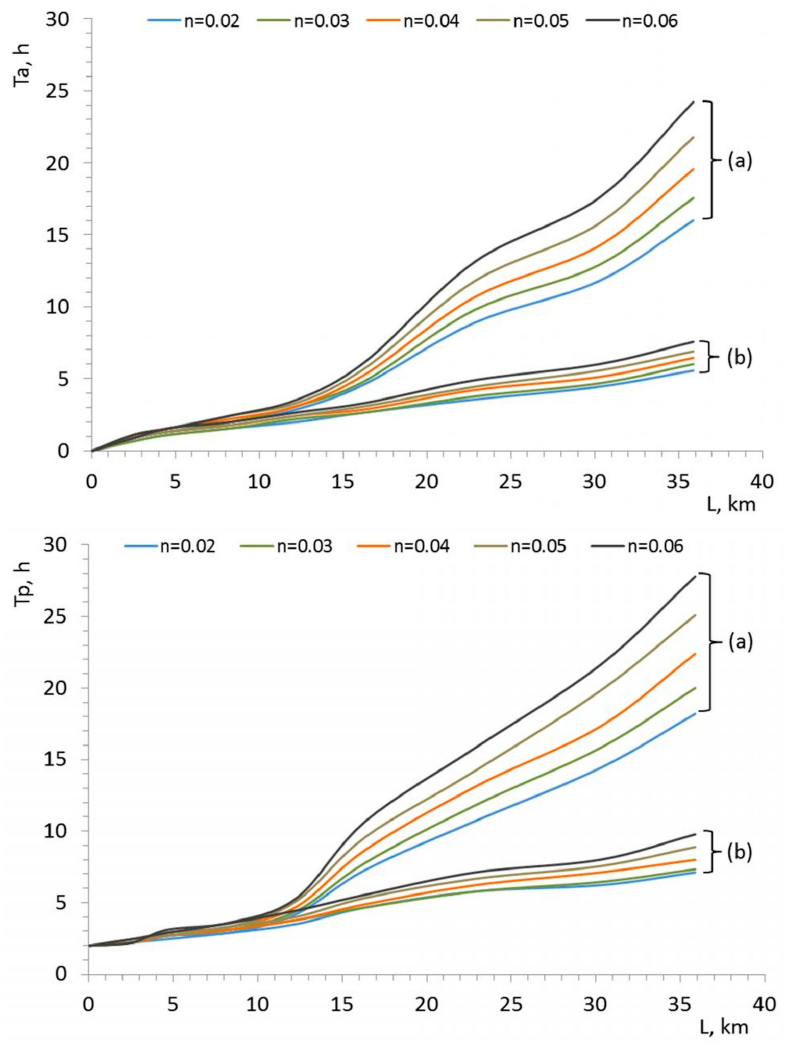
Figure 8. Flood wave arrival time (Ta) ( top ); and time to peak (Tp) ( bottom ) versus distance from the dam (L), with the: DEM SRTM ( a ); and the DEM SRTM TR ( b ) for different values of the roughness